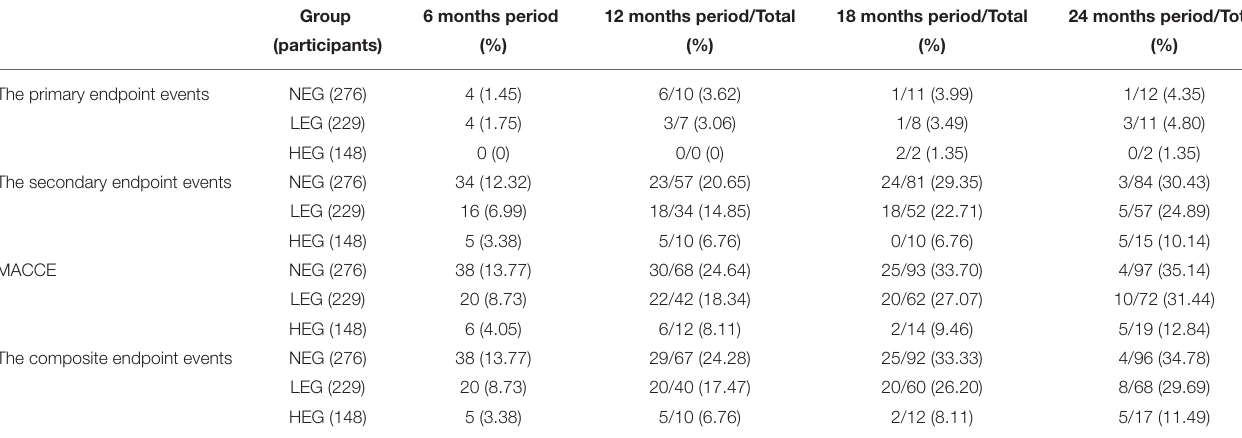
TABLE 2 | The incidence of the cumulative endpoint events.